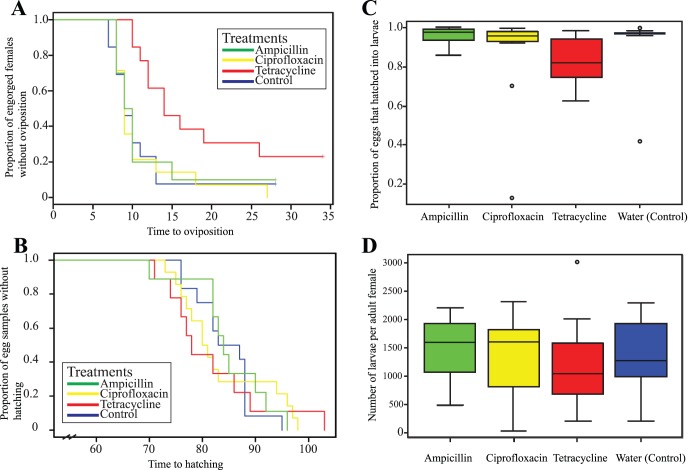
Kaplan-Meier (time-to-event) plots of the preoviposition period and the incubation periods, and boxplots representing egg hatching rate, and the number of larvae from engorged Ixodes pacificus females.2A) A Kaplan-Meier plot where each colored line corresponds to the fraction of adult female ticks that had not started laying eggs on a particular day after the ticks were injected with antibiotics or water (control). Vertical dashes on the colored lines represent censorship, where a tick that had not started to lay eggs died and was dropped from the study. The tetracycline group (red) took significantly longer to start laying eggs compared to the rest (P<0.05) 2B) A Kaplan-Meier plot where the colored lines represent the proportion of egg samples laid by individual ticks whose eggs had not finished hatching into larvae a certain number of days after oviposition began. 2C) A boxplot showing the hatching rate, or the fraction of tick eggs that successfully hatched into larvae, in the four treatment groups. Each individually colored box represents the hatching rate distribution of eggs laid by each female tick in the group. 2D) A boxplot specifying the distribution of the total number of larvae each female yielded. No significant difference in (C) hatching rate or (D) the number of larvae was present between treatment groups (P<0.05). Circles outside the boxes in (C) and (D) represent outliers. The colors in all the plots in the figure correspond to specific treatment groups: blue - ampicillin, yellow - ciprofloxacin, red - tetracycline, green - injection with water (control).